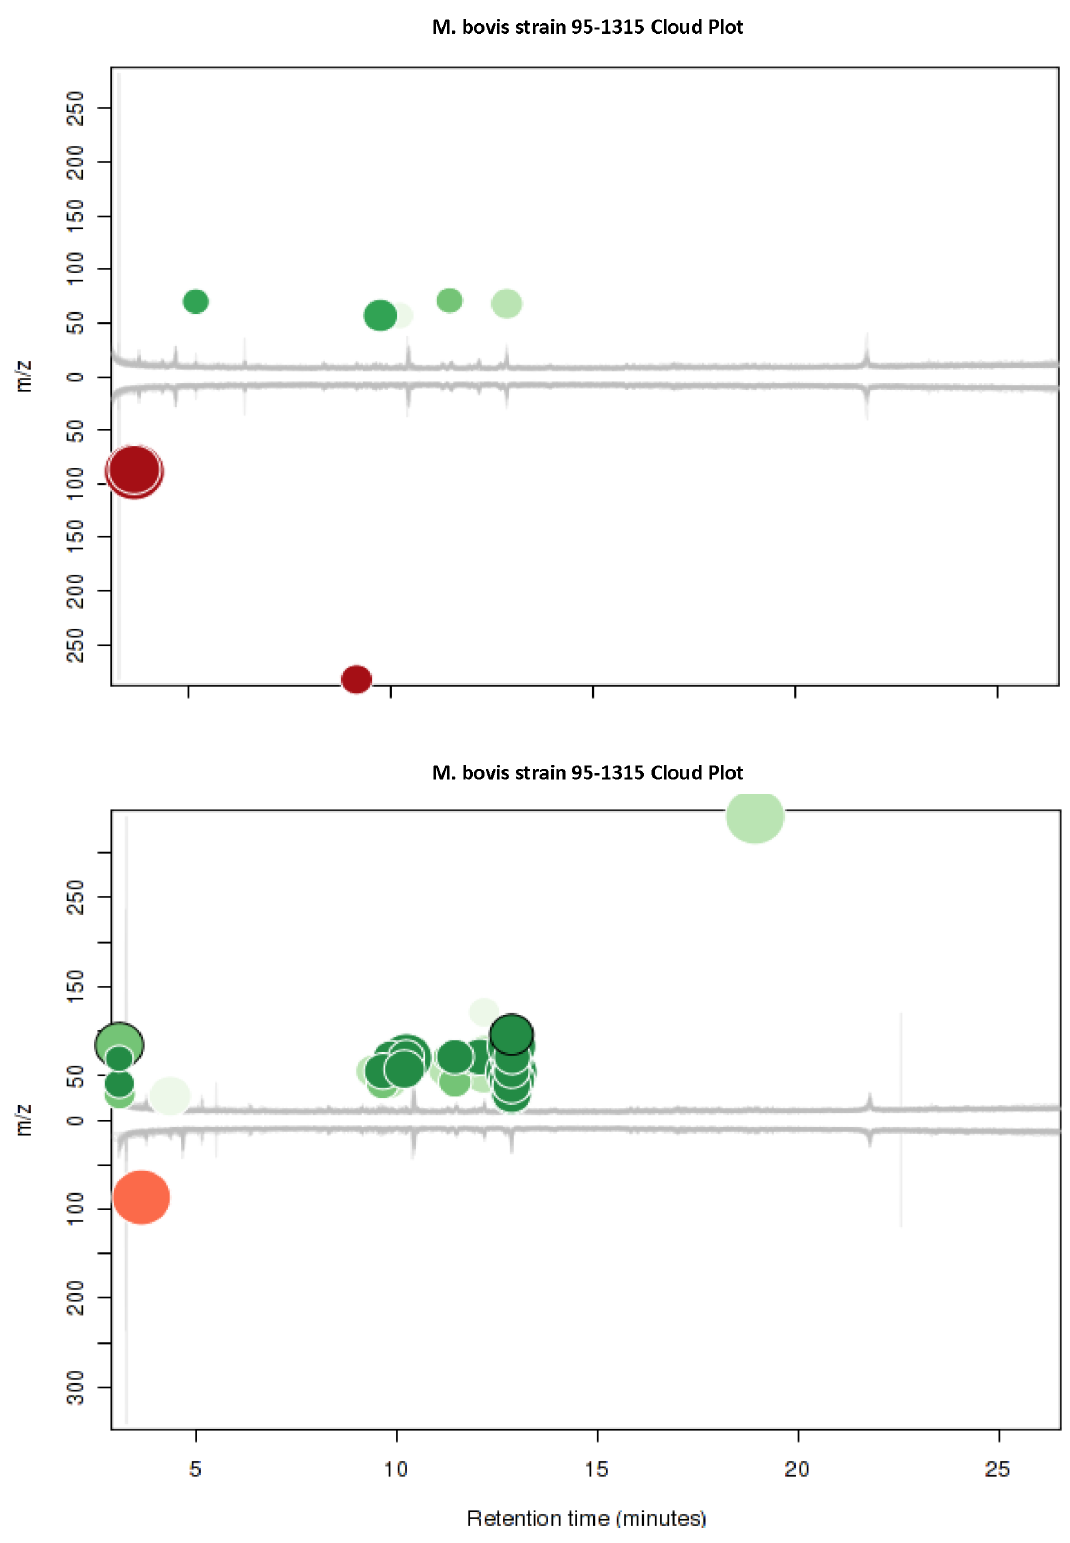
Figure 1. Cloud plots of aligned GC/MS chromatograms generated with XCMS Online. ( A ) Control vs. M. bovis strain 95-1315 analysis. ( B ) Control vs. M. bovis strain 10-7428 analysis. Control treatment group chromatograms are depicted below the X-axis, and M. bovis -infected chromatograms are positioned above. Up-regulated features of statistical significance are identified with green-colored circles located at the top of the plot, and down-regulated features are identified by red-colored circles located at the bottom of the plot. The color intensity of each circle represents the statistical significance of the feature difference, with brighter circles having lower p-values. The diameter of each circle represents a log-fold increase or decrease in abundance (i.e., larger circles correspond to peaks with greater fold differences). doi:10.1371/journal.pone.0089280.g001 PLOS ONE |